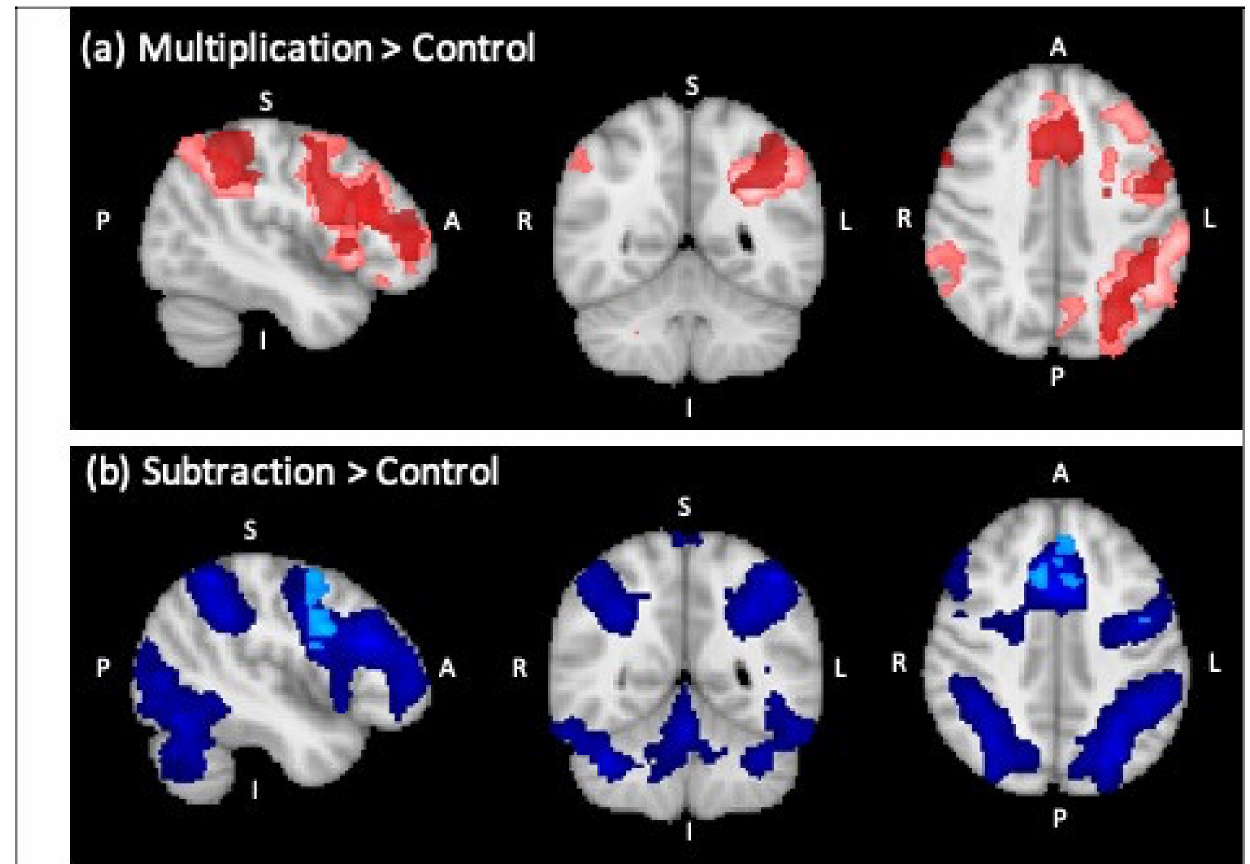
Figure 2. Overlay of regions of significant BOLD signal change for the control group in dark color and for RM in light color (sagittal, coronal and axial view from left to right). ( a ) Multiplication versus control (cluster threshold Z = 2.3) (RM in light red, control group in dark red), ( b ) subtraction versus control (cluster threshold Z = 2.3) (RM in light blue, control group in dark